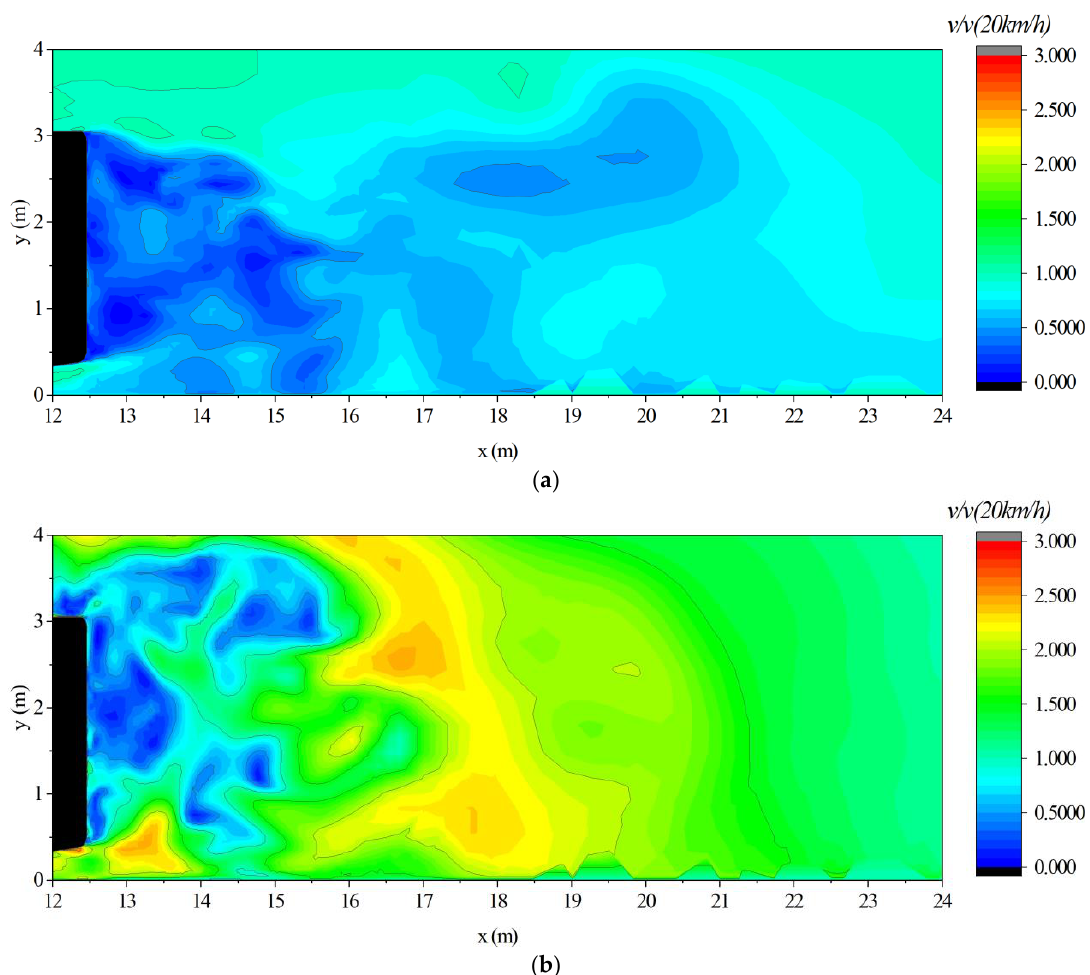
Figure 10. Vertical velocity distributions at 20 km/h on the symmetry plane for ( a ) symmetrical flow and ( b ) 2 m/s side wind.